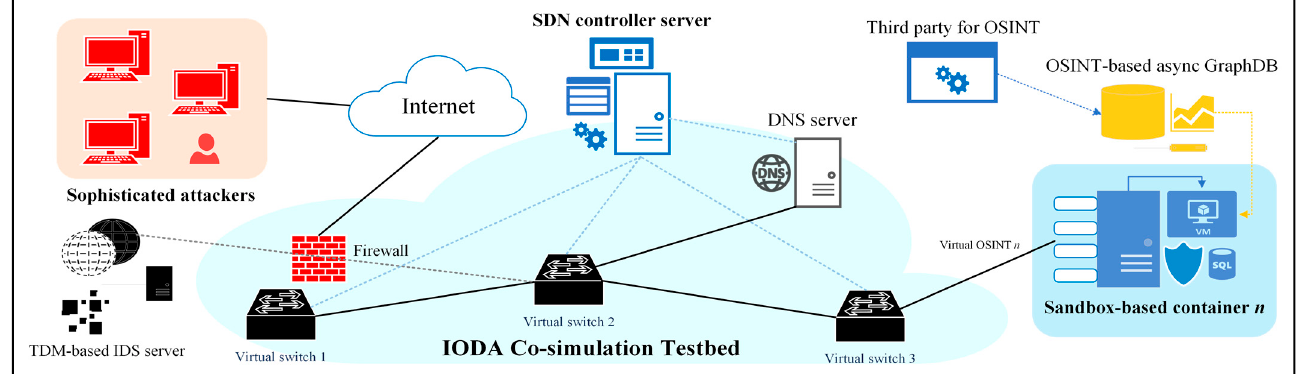
Figure 5. Overview of SDN-based IODA testbed with deceptive concepts, i.e., LPC-MTD and HS-Decoy.